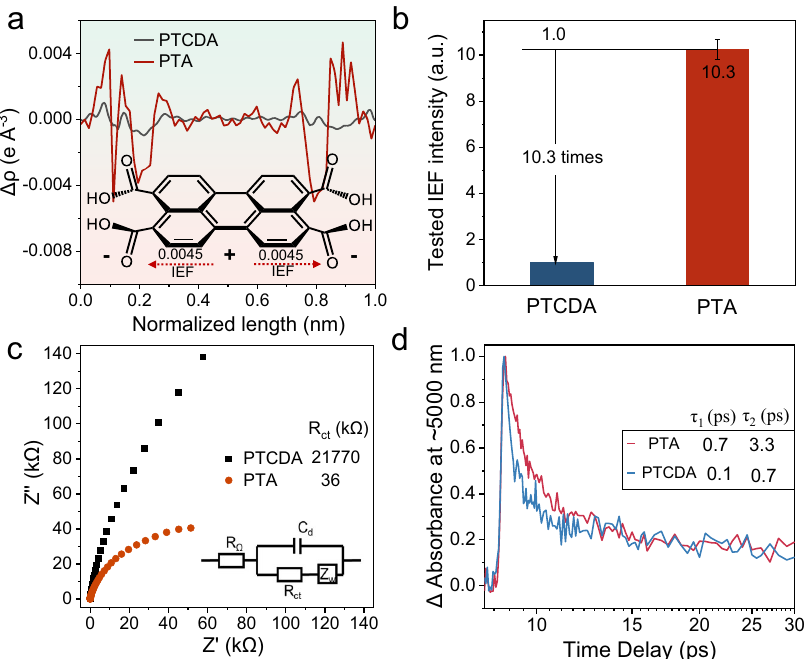
Fig. 4 IEF drives charge separation. a Excited charge density difference between the PTA and PTCDA cells (set with carbonyl oxygen). b The tested IEF intensity, c impedance and d transient absorption decay kinetics at ~5000 nm of PTCDA and